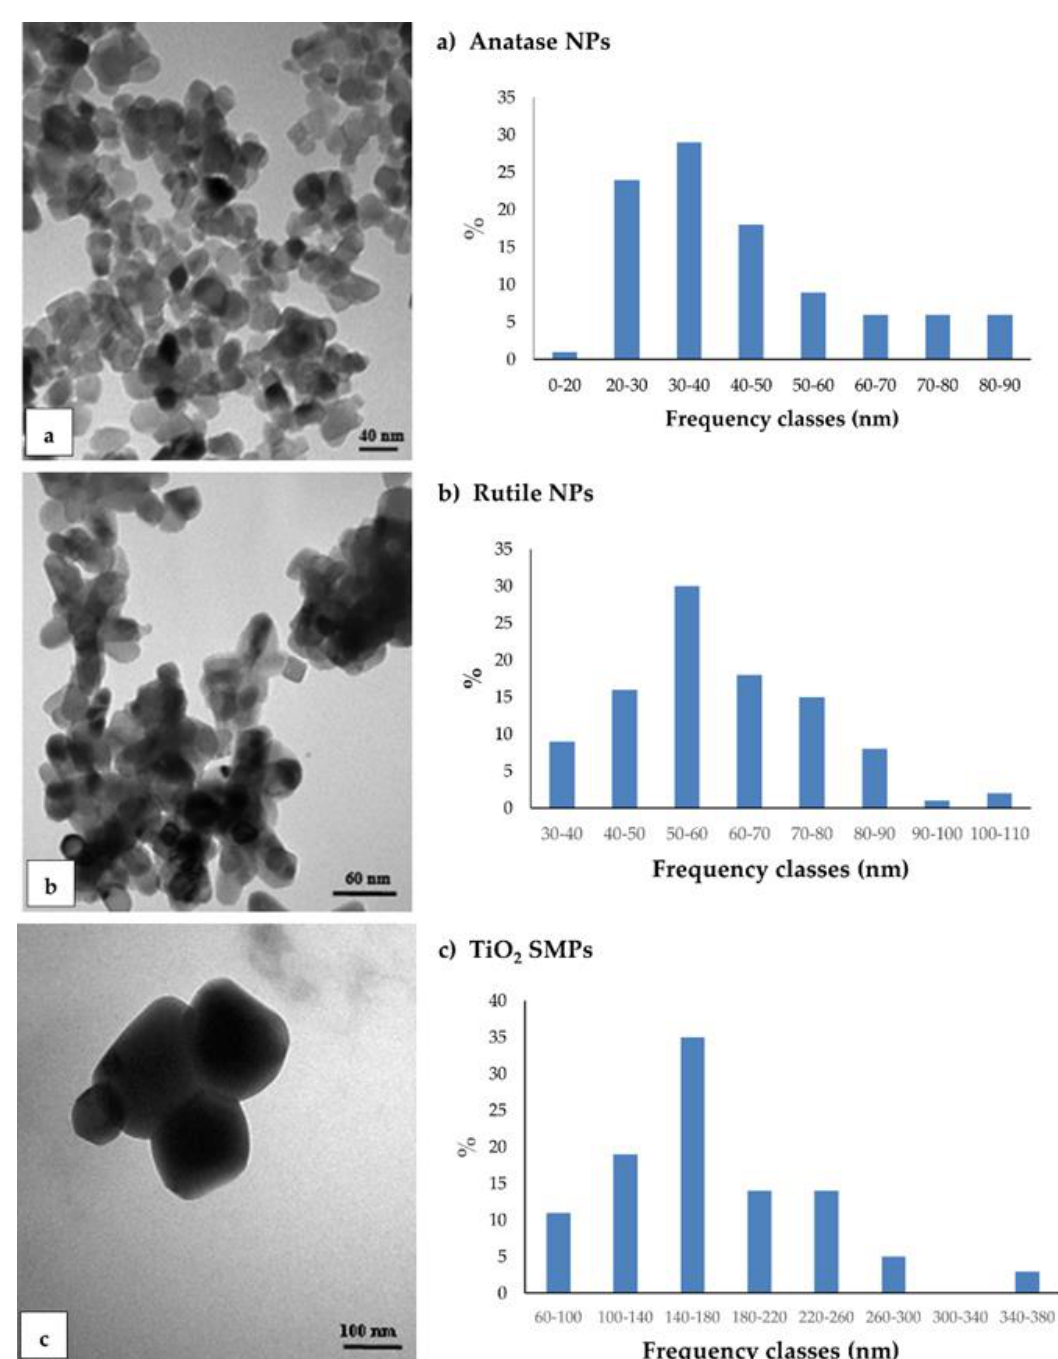
Figure 1. Transmission electron microscopy (TEM) observation and size distribution of TiO 2 particles grouped in frequency classes for the major axis: ( a ) anatase nanoparticles (NPs); ( b ) rutile NPs; ( c ) TiO 2 submicron particles (SMPs). ImageJ program was used for TEM images elaboration at sizes measurement.